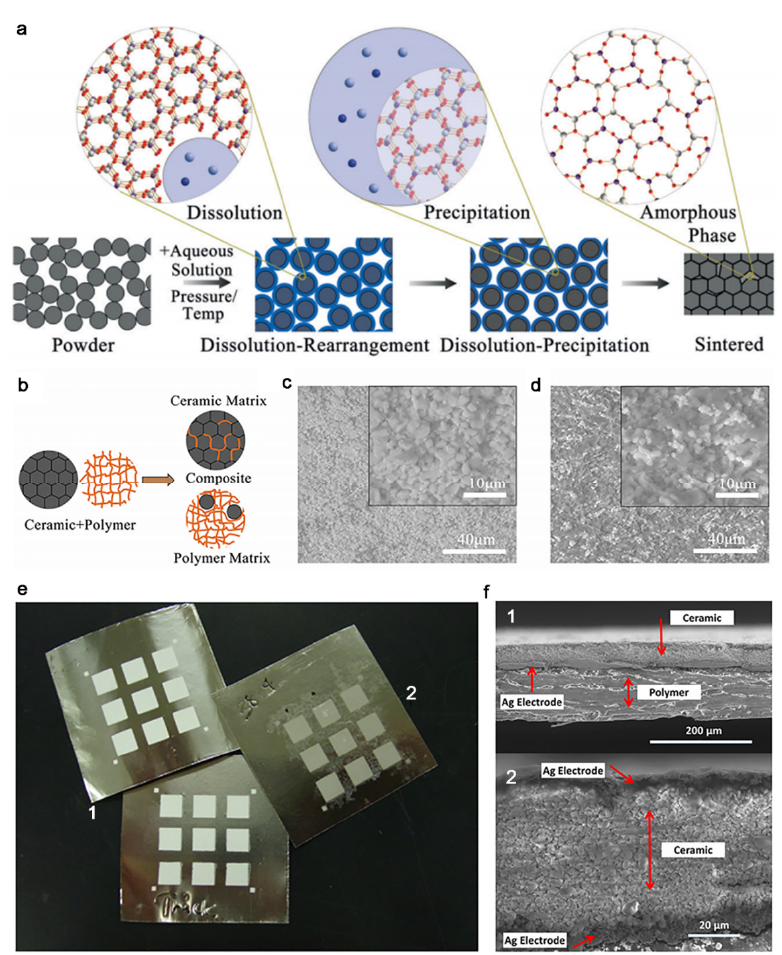
Figure 3. ( a ) Scheme of the cold sintering from particle precursors. Molecular structures at the grain boundary have been magnified. Reproduced with permission [46]. Copyright 2016, Wiley-VCH. ( b ) Scheme of cold co-sintered ceramic-polymer composites. ( c , d ) Scanning electron microscope (SEM) image of 90LM–10PTFE ( c ) and 40LM–60PTFE ( d ) composites, which are cold co-sintered at 120 °C and 350 MPa for 20 min. The white region is the Li 2 MoO 4 ( LM) phase, while the black region is PTFE phase. Reproduced with permission [54]. Copyright 2016, Wiley-VCH. ( e ) Capacitor arrays on Nickel foils by printing (1) or cold sintering (2). ( f ) SEM image on cross-sectional view of a cold-sintered Li 2 MoO 4 , showing a single-layered capacitor structure: (1) cold-sintered structure on polyethylene terephthalate film at low-magnification and (2) top and bottom electrodes in high-magnification image. Reproduced with permission [52]. Copyright 2016, The American Ceramic Society.